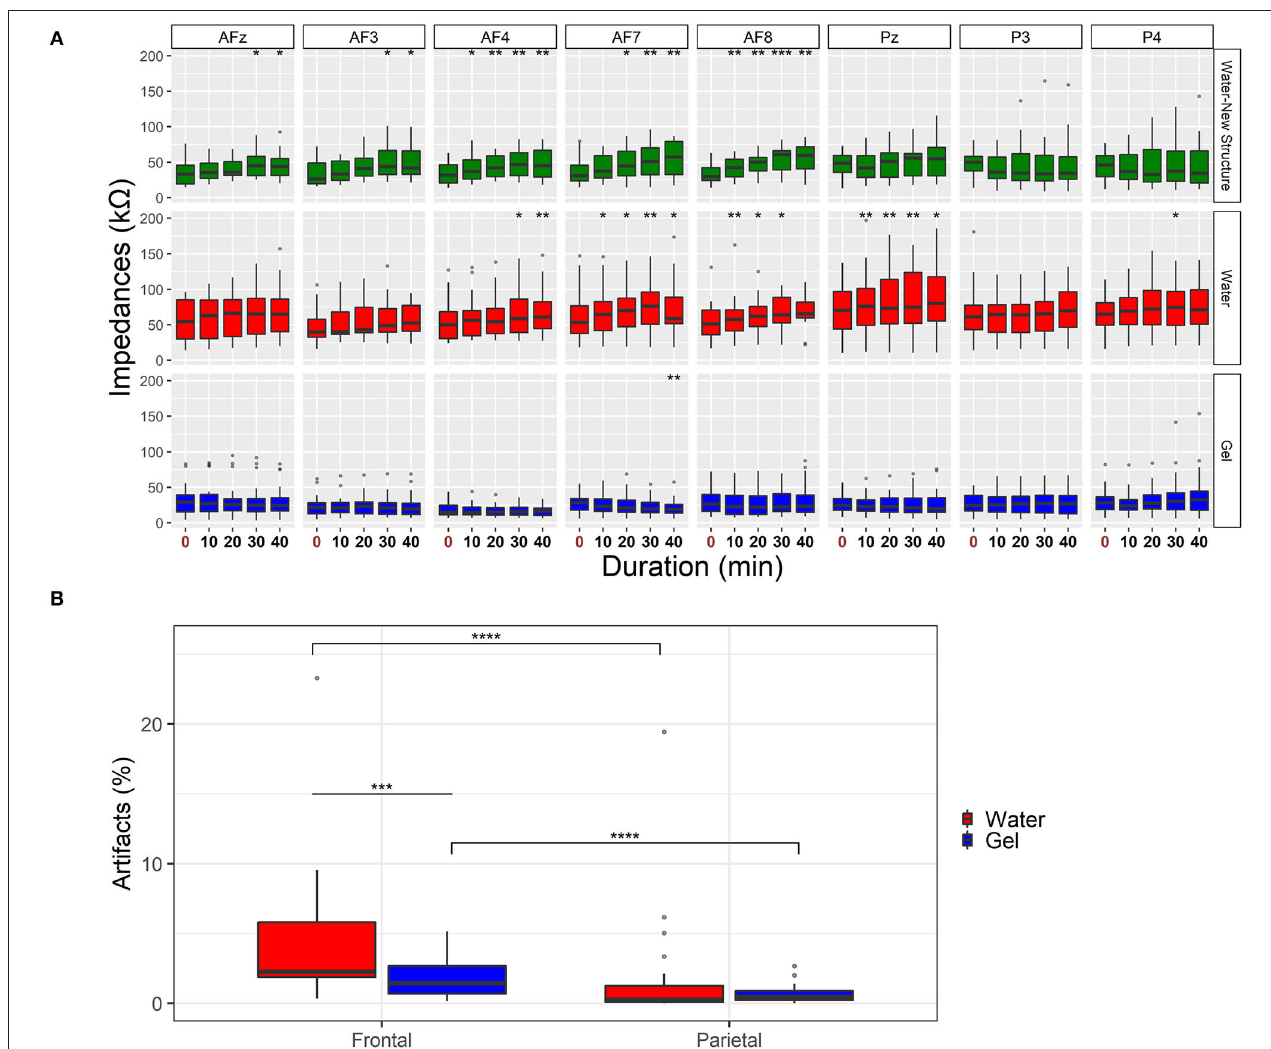
FIGURE 4 | Analysis of impedances and percentage of artifacts. (A) Analysis of the stability of impedances over time for water-based (in red), gel (in blue), and water electrodes embedded on Mindtooth Touch headset. The asterisks show the results of the Wilcoxon signed-rank (Bonferroni corrected) test of the impedances of water and gel electrodes compared with the start point (* p < 0.05, ** p < 0.01). (B) Percentage of artifacts in EEG signals. The boxplots show the distributions of the artifacts that occurred through the gel (blue) and water (red) acquisition system. Results have been obtained by averaging the electrodes in two groups: Frontal (AFz, AF3, AF4, AF7, and AF8) and Parietal (P3, P4, and Pz) channels. The asterisks show the results of the Wilcoxon signed-rank test (*** p < 0.001, **** p <